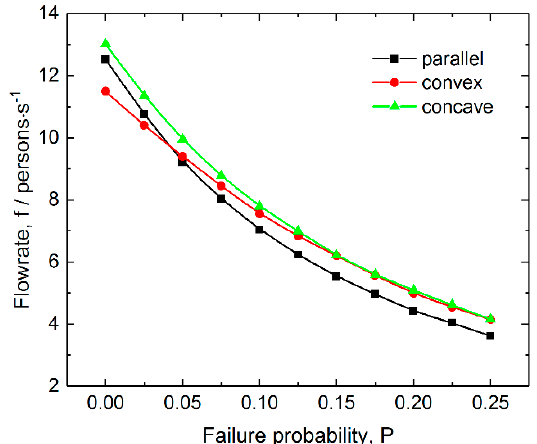
Figure 3. Total flowrate as a function of checking failure probability for the three layouts of inspection points. The density of pedestrian and delay are 3.5 persons/m 2 and 3 s, respectively.